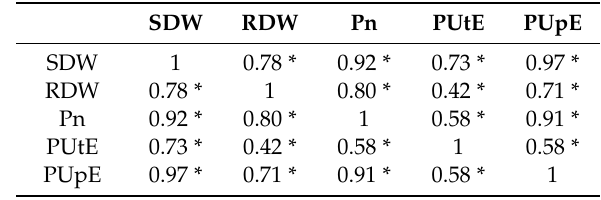
Table 7. Relationship between shoot dry weight (SDW), root dry weight (RDW), photosynthesis